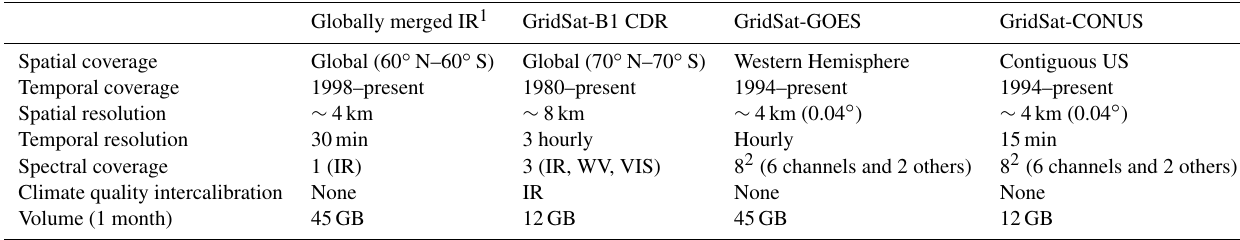
Table 2. Comparison of GridSat-GOES and GridSat-CONUS with similar currently available